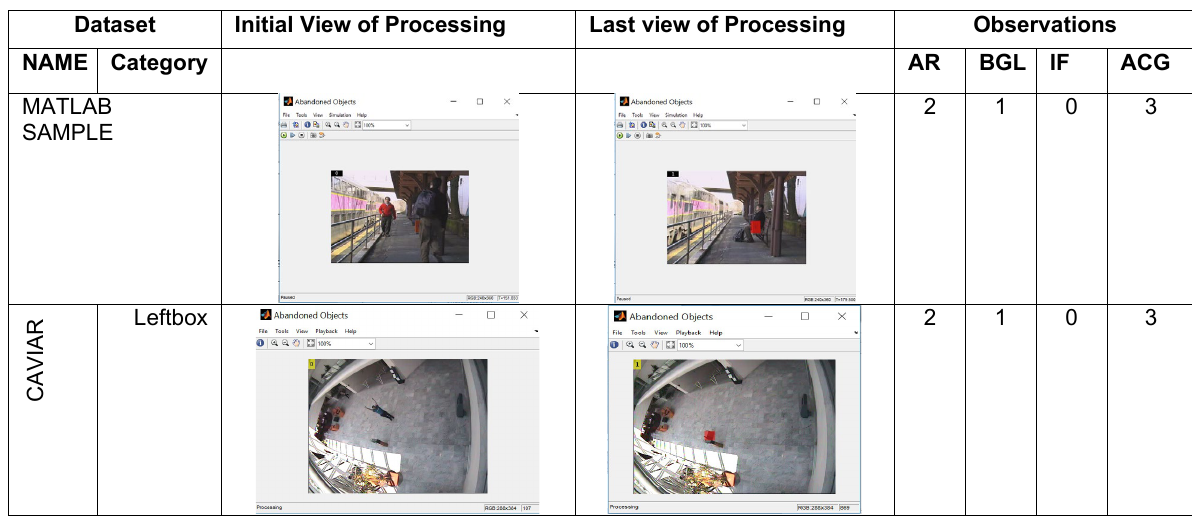
Table 3. Execution Results on Benchmark Datasets and observations